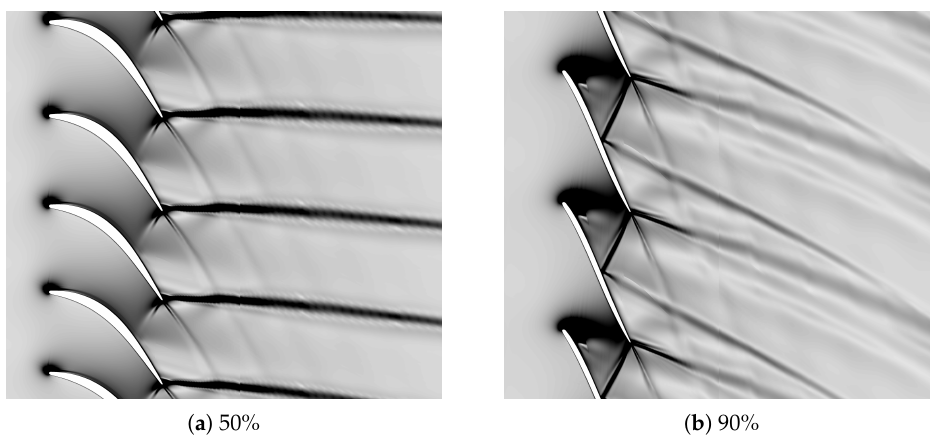
Figure 3. Steady solution (numerical Schlieren) in the rotor domain at 50% and 90% channel